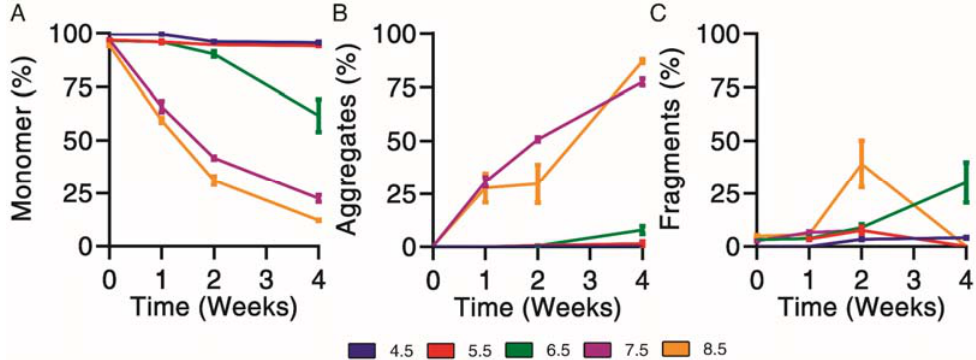
Figure 3. Kinetics of physical degradation determined by size exclusion chromatography, separating ( A ) monomer from ( B ) aggregate and ( C ) fragment physical impurities of exenatide reconstituted at pH 4.5–8.5 after incubation at 37 °C for 4 weeks. ( n = 3, mean ± SEM).